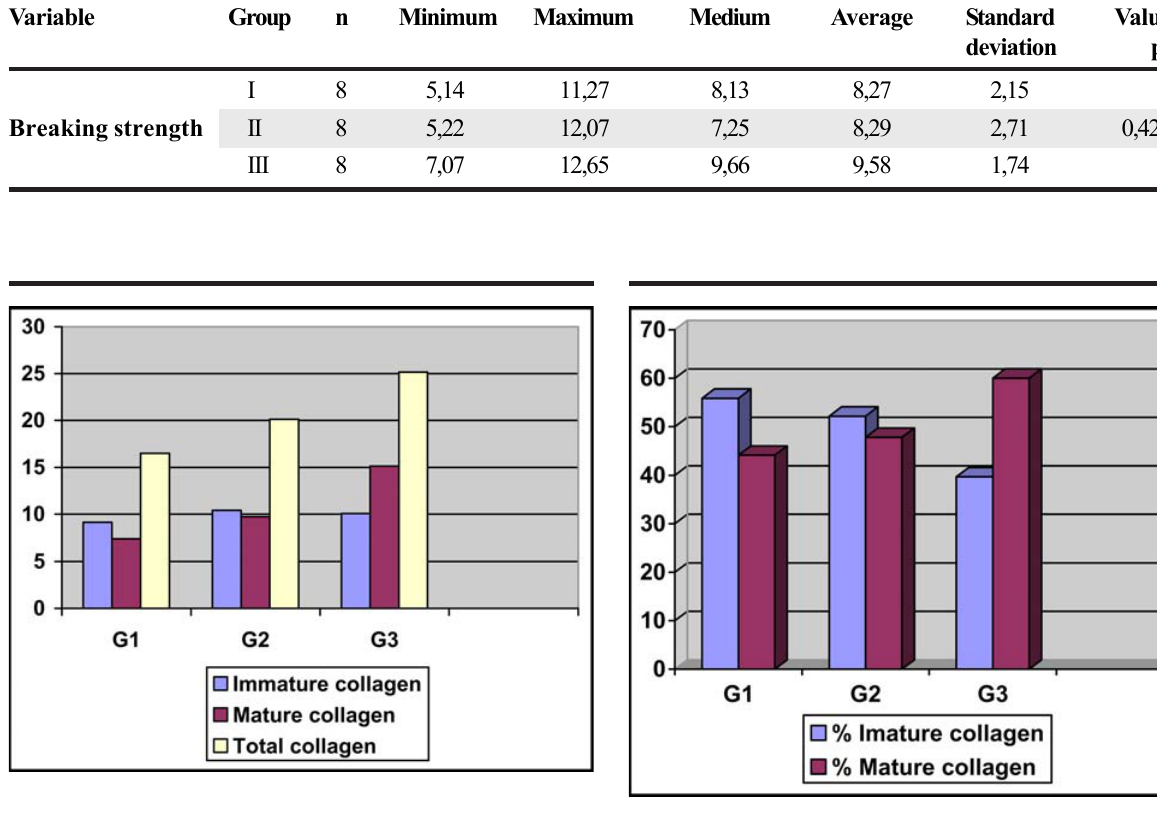
FIGURE 1 - Behavior of average collagen concentrations in the three groups